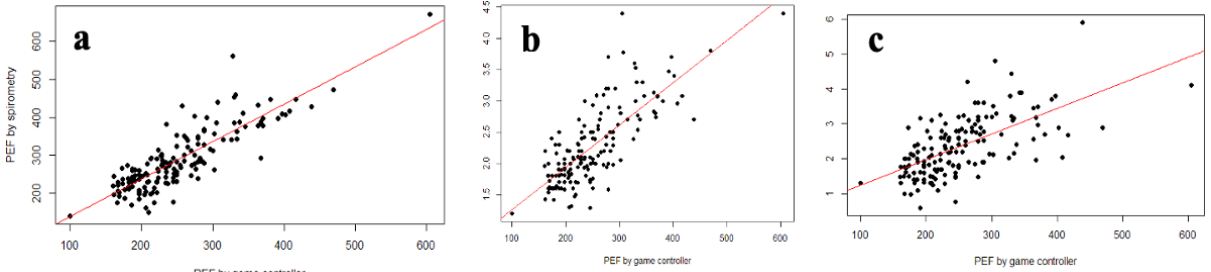
Figure 2. Correlation between PEFGC and selected conventional spirometry measurements. PEFGC shows good correlation with PEFspiro (a; r =0.83, P <.001), FEV 1 (b; r =0.74, P <.001) and FEF 25-75 (c; 25-75 =0.65, P <.001). PEFGC: peak expiratory flow measured by the game controller. PEFspiro: peak expiratory flow measured by conventional spirometry. FEV 1 : forced expiratory volume in 1 second. FEF 25-75 : forced expiratory flow at 25%-75% pulmonary